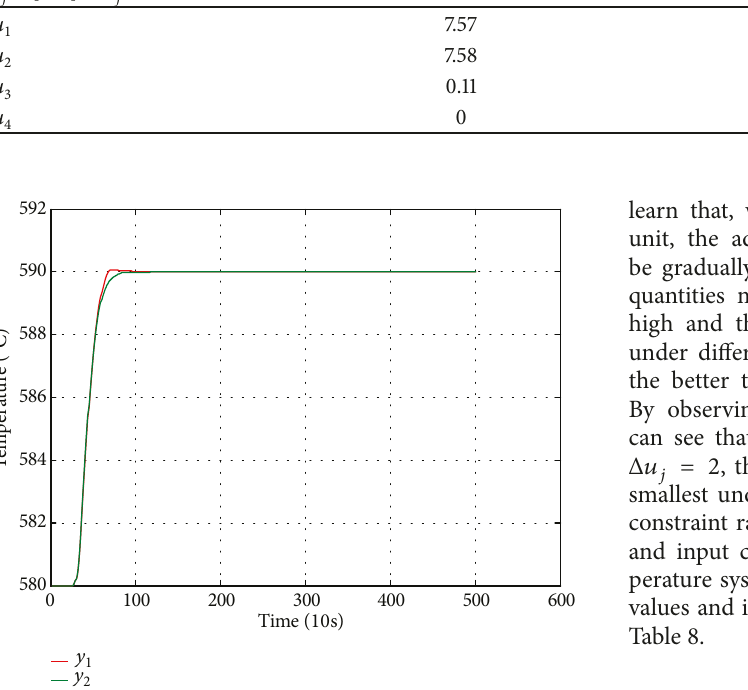
the largest fluctuation. Therefore, in the existing data, we can roughly consider that the maximum upper bound value of the constraint range of the control quantities is